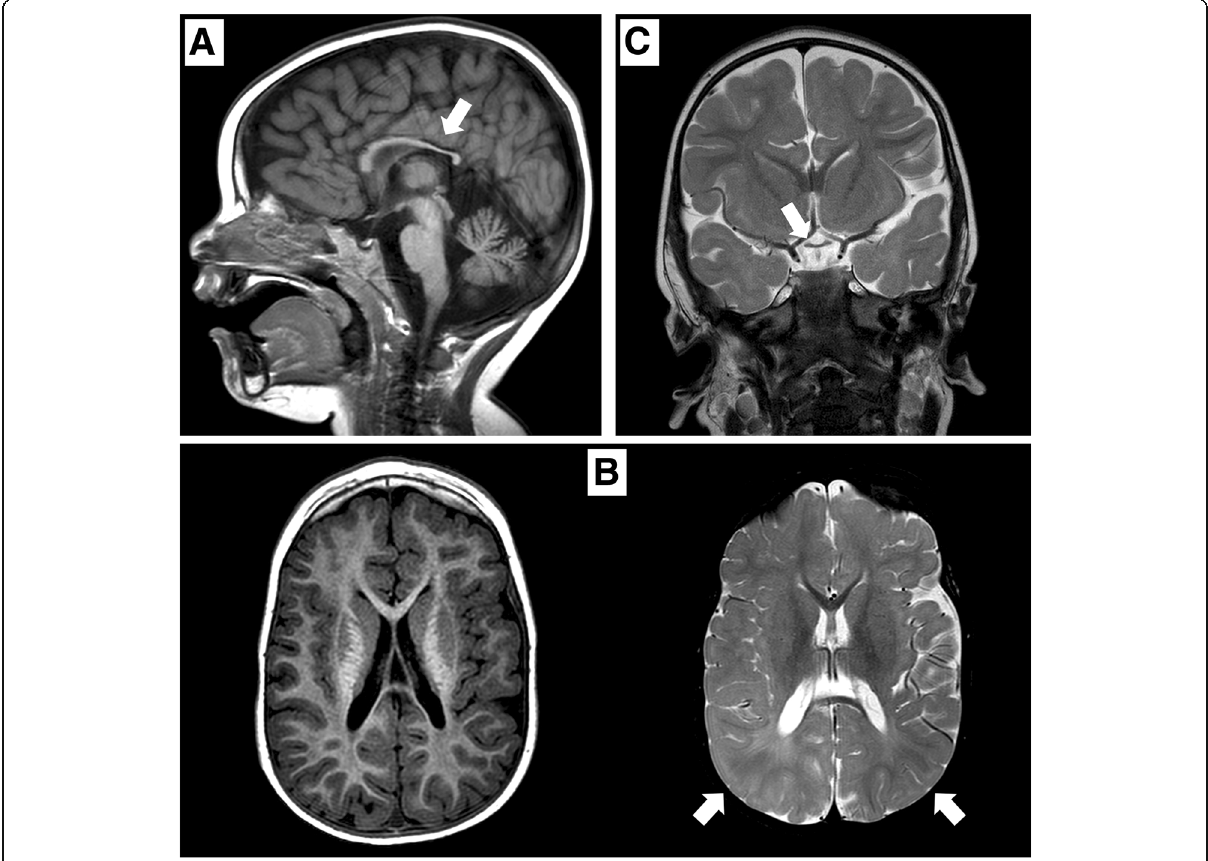
Fig. 1 a Sagittal T1-weighted image showing hypoplasia of the corpus callosum (white arrow). b Axial T1-weighted (left) and axial T2-weighted (right) images showing hypoplasia of the corpus callosum and altered, poorly-defined signal in the bilateral subcortical parietal white matter (white arrows). c Coronal T2-weighted image showing hypoplasia of the optic chiasm (white